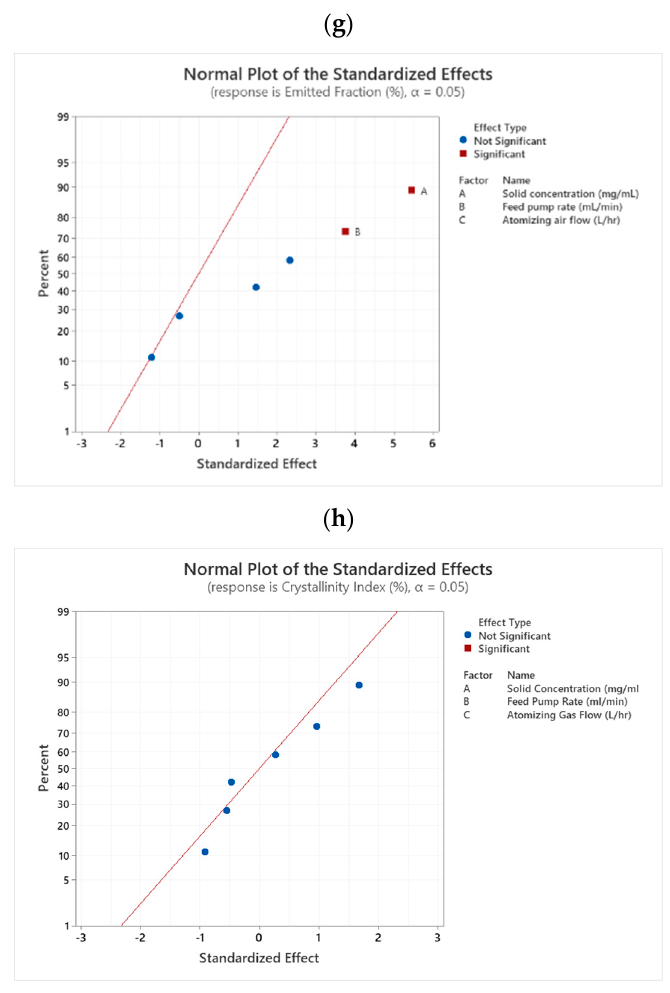
Figure 8. Pareto charts illustrate the standardized effect of the independent variables (A: Solid concentration, B: Feed pump rate, C: Atomizing gas flow) and their interactions on MMAD ( a ), FPF ( b ), EF ( c ), and CI ( d ) of the inhalable cocrystal formulation. The factors that cross the vertical red reference line indicate that their effects are statistically significant. Normal probability plots ( e – h ) are used to determine the magnitude, direction and the importance of the effects of the independent variables and their interactions on MMAD ( e ), FPF ( f ), EF ( g ), and CI ( h ). Effects further from 0 are more statistically significant. The Pareto charts and normal probability plots both indicate that the feed pump rate is a significant parameter affecting the MMAD; the solid concentration and feed pump rate are the significant parameters affecting the FPF and EF; and the CI is not significantly affected by any of the studied processing parameters.